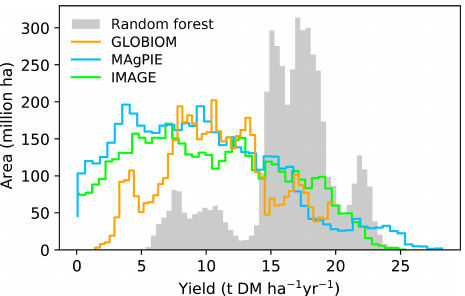
Figure 5. Histograms of best crop yields in our RF yield map and yield maps used in the three IAMs. Only regions where yield values are available in all the four maps are used to generate the histogram.